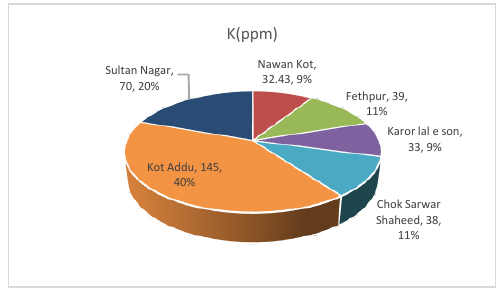
Figure 15: Calcium ions concentration vales of the Layyah and Muzzafargarh sites.